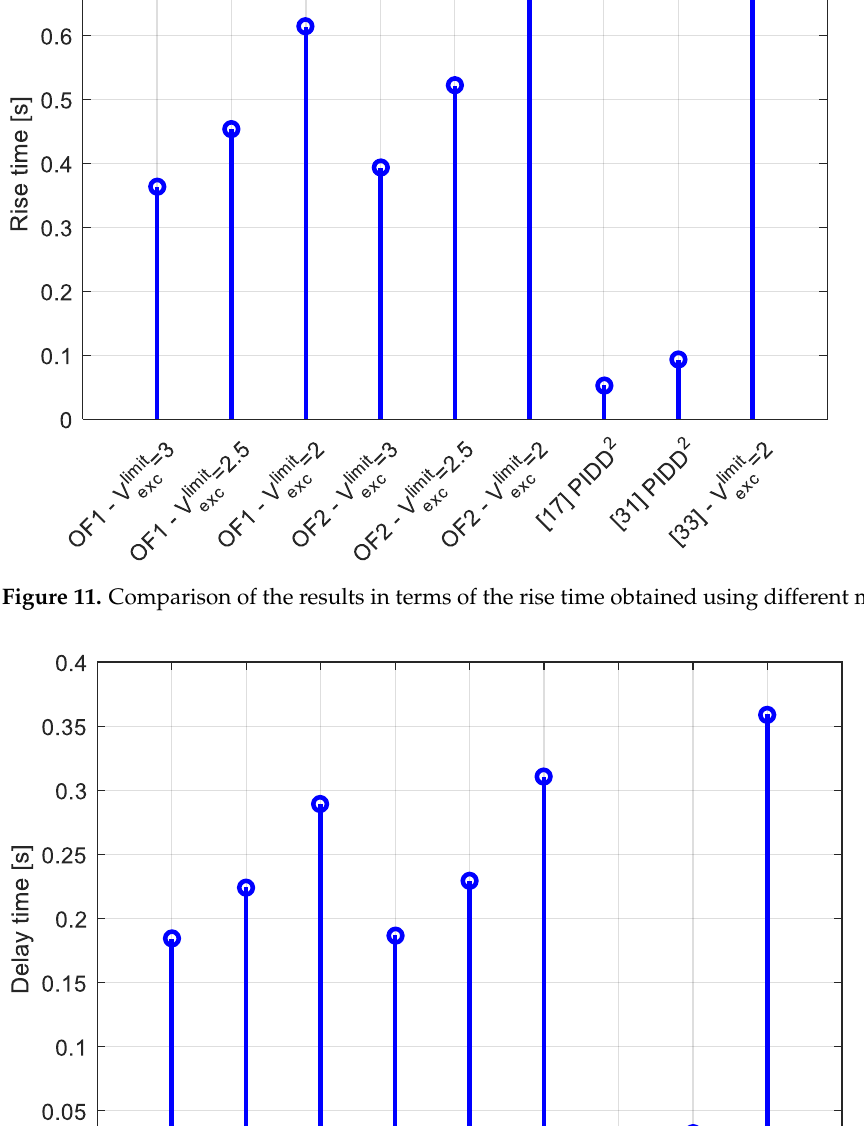
Figure 10. Comparison of the results in terms of the maximum value of the excitation voltage ob- tained using different methods.